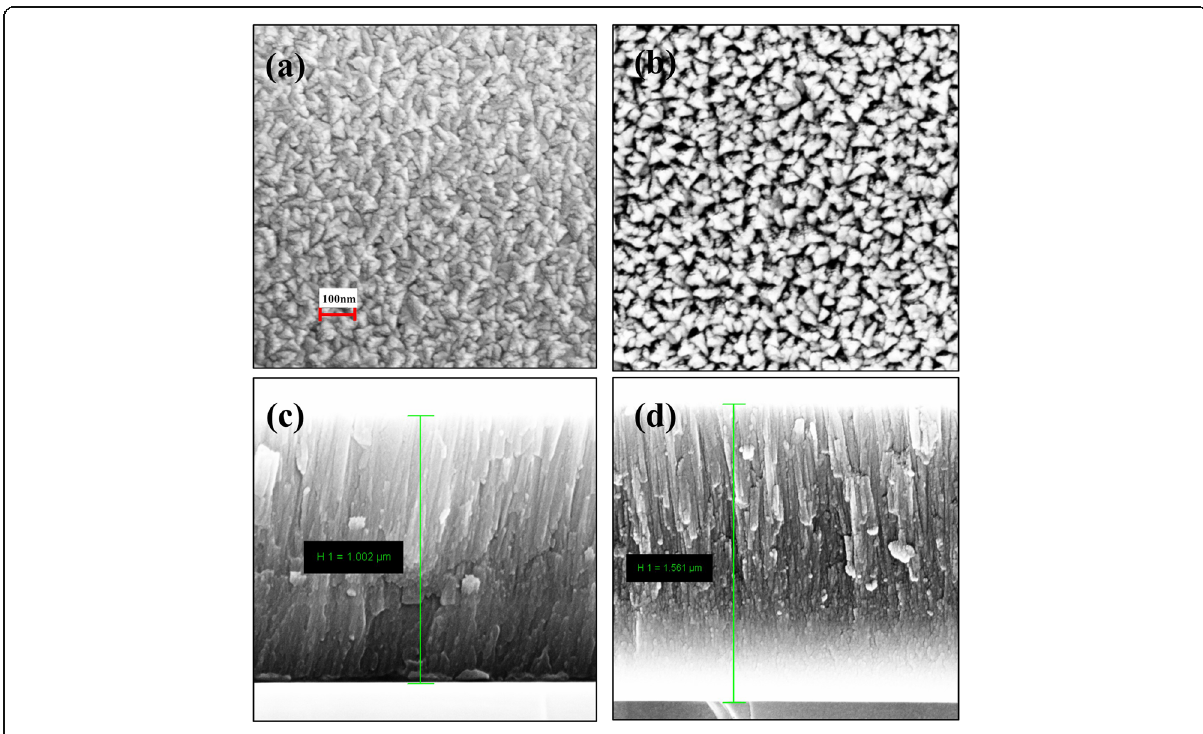
Fig. 3 Planar and cross-sectional FESEM images of S3 ( a , c ; 15 sccm) and S5 ( b , d ; 25